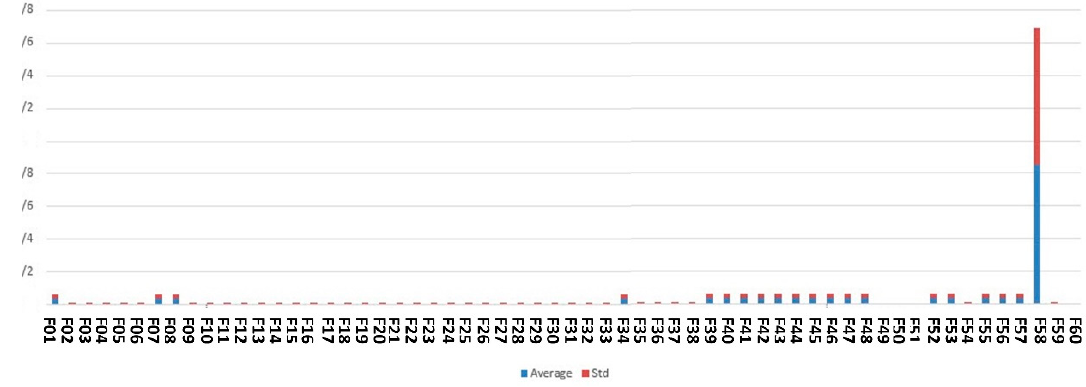
used in this study.